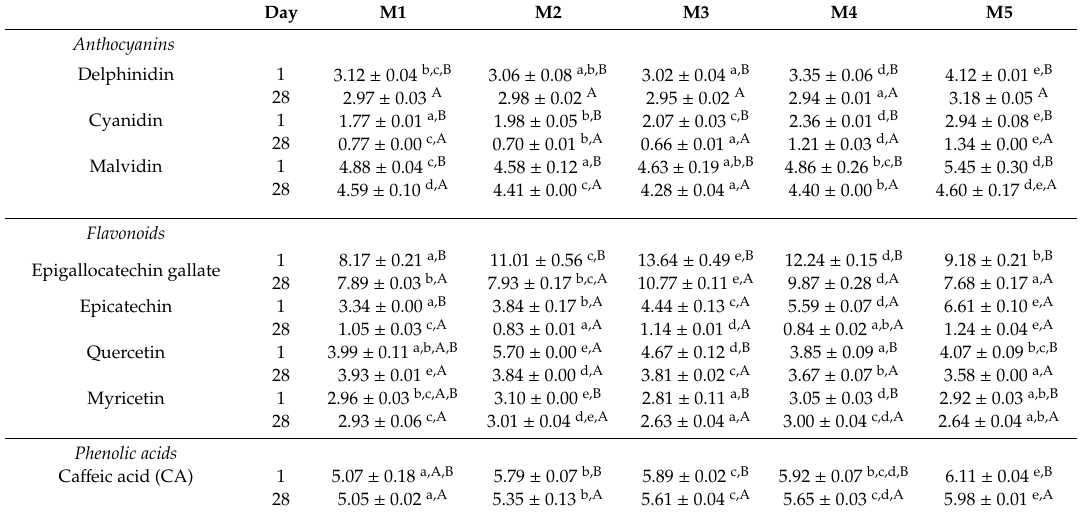
Table 4. Individual phenolic compounds (IPC) of aerated CBJ–gelatin gels at day 1 and day 28 under